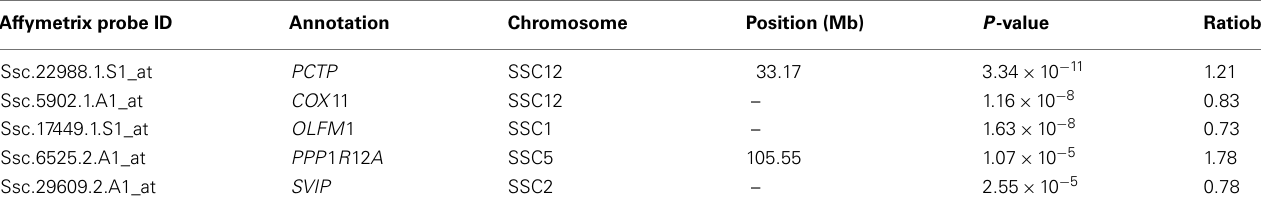
TableA8 | Differentially expressed probes conditional on copy number of PCTP ASGA0054039C.